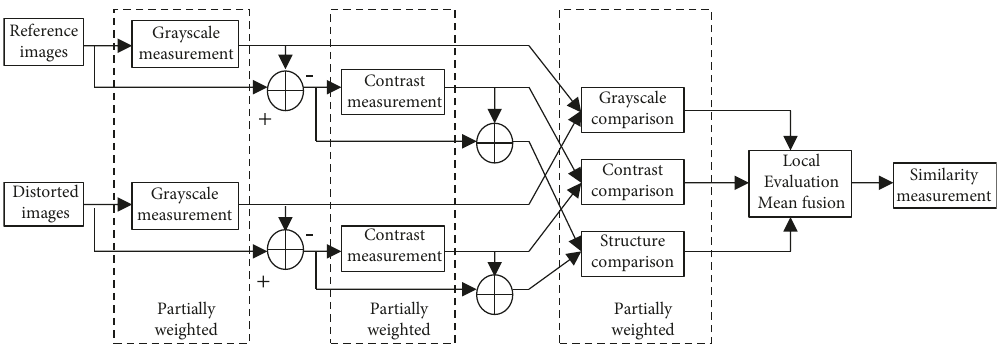
Figure 2: Principle of local weighted fusion of SSIM